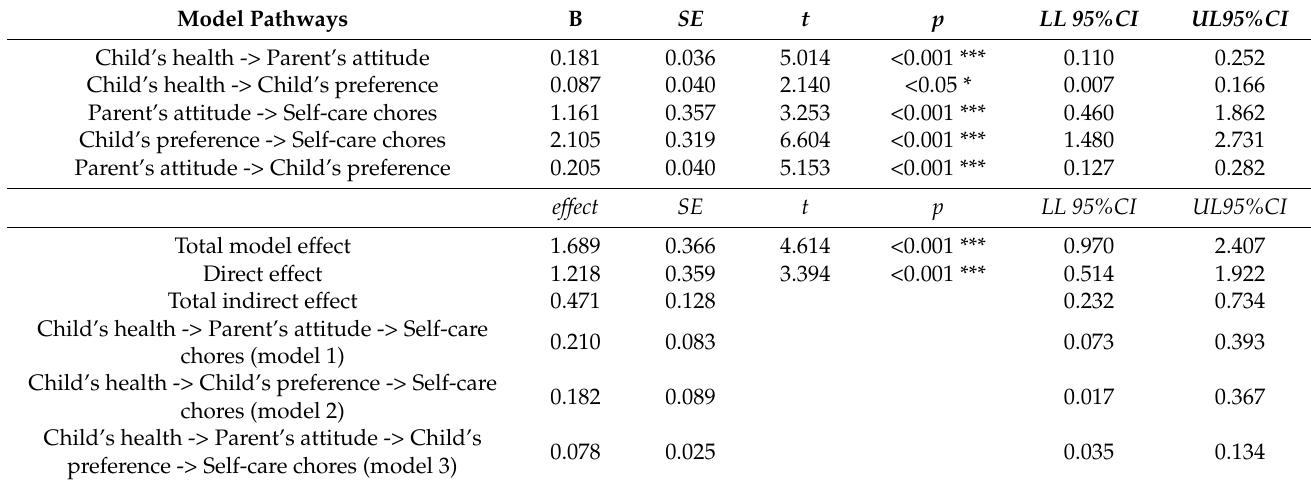
Table 3. Serial mediation effects on the relationship between Child’s health and Self-care